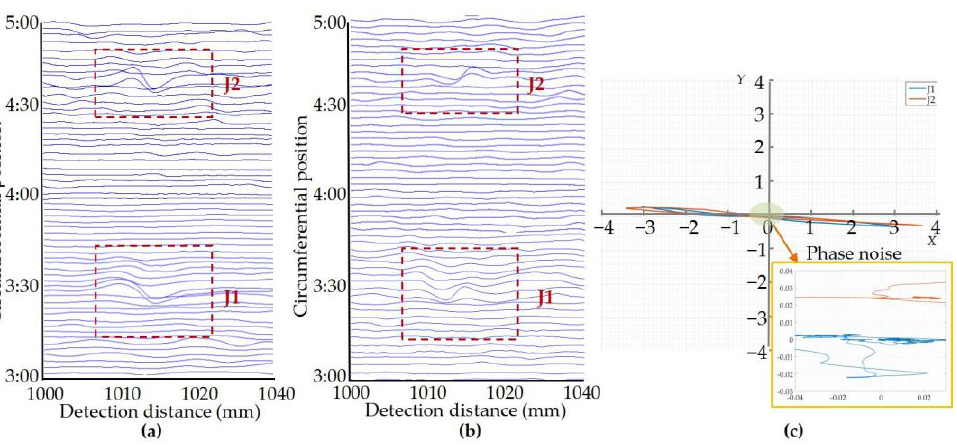
Figure 15. Results of pull-off experiments for sensor jitter: ( a ) In-phase components of the sensor jitter signals; ( b ) Orthogonal components of the sensor jitter signals; ( c ) Amplitude–phase composite figure for the sensor jitter.